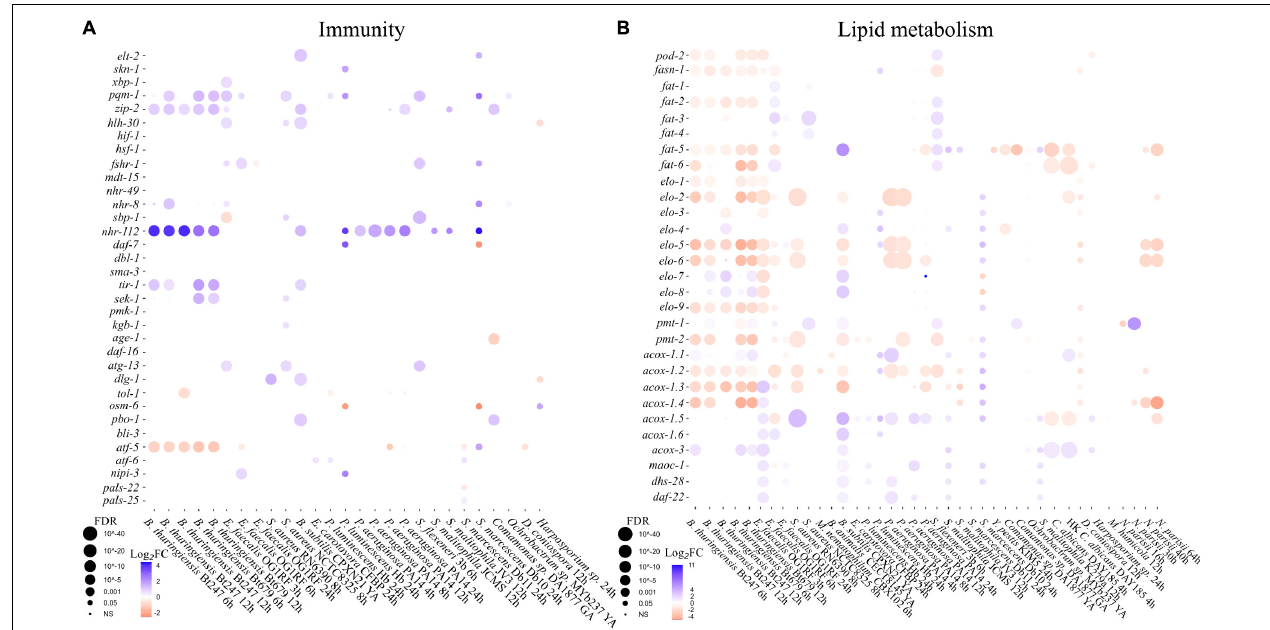
FIGURE 2 | C. elegans immune regulation and lipid metabolism genes change their expression in a microbe-specific manner. Gene expression plots (bubble plots) that represent changes in gene expression as log 2 Fold Change (Log 2 FC) in a color heatmap and the adjusted p -value (FDR) as the diameter of the points. Published transcriptomic datasets were not re-analyzed from raw data, or re-scaled, therefore datasets from different studies cannot be compared quantitatively, only qualitatively. Detailed information about the datasets shown can be found in Supplementary Table 2 . (A) Shows gene expression changes in a list of selected immunity genes (Pukkila-Worley and Ausubel, 2012; Martineau et al., 2021). (B) Shows gene expression changes in a list of selected lipid metabolism genes (Watts and Ristow,